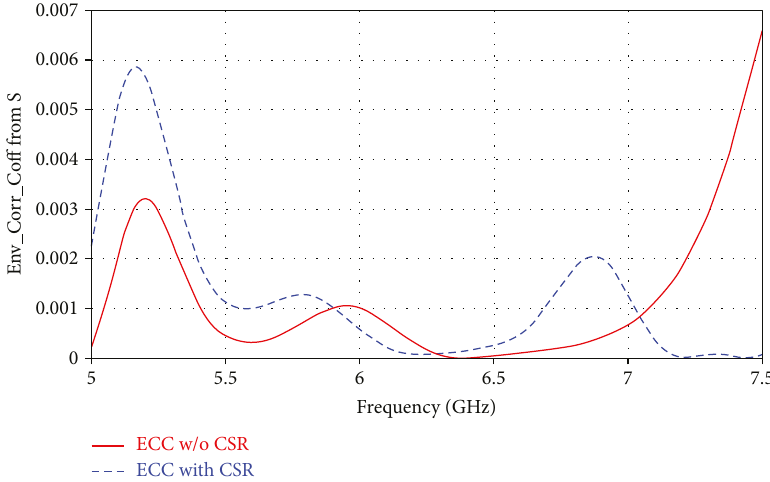
Figure 11: ECC of MIMO system with and without MTM-CSR matrix structure.